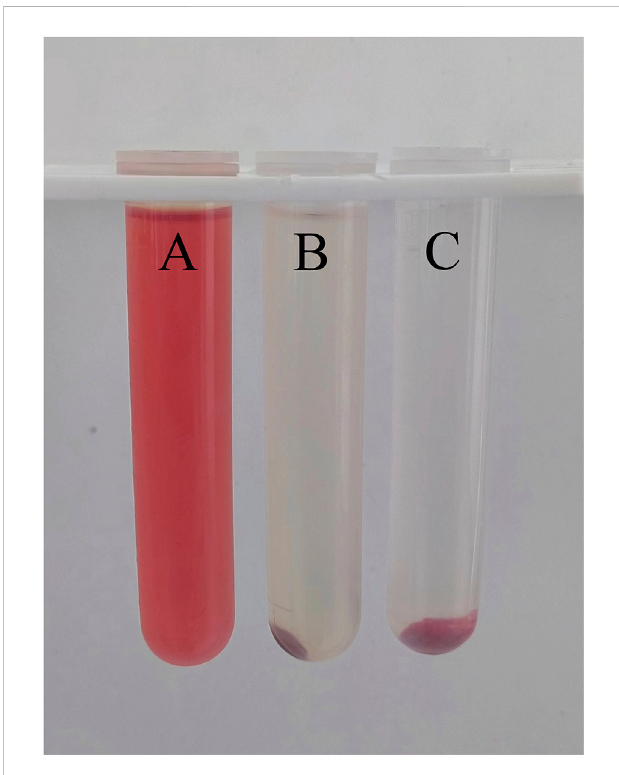
FIGURE 8 The result diagram of FDBM hemolysis (A is distilled water, B is FDBM extraction solution, C is normal saline) (n = 10 per